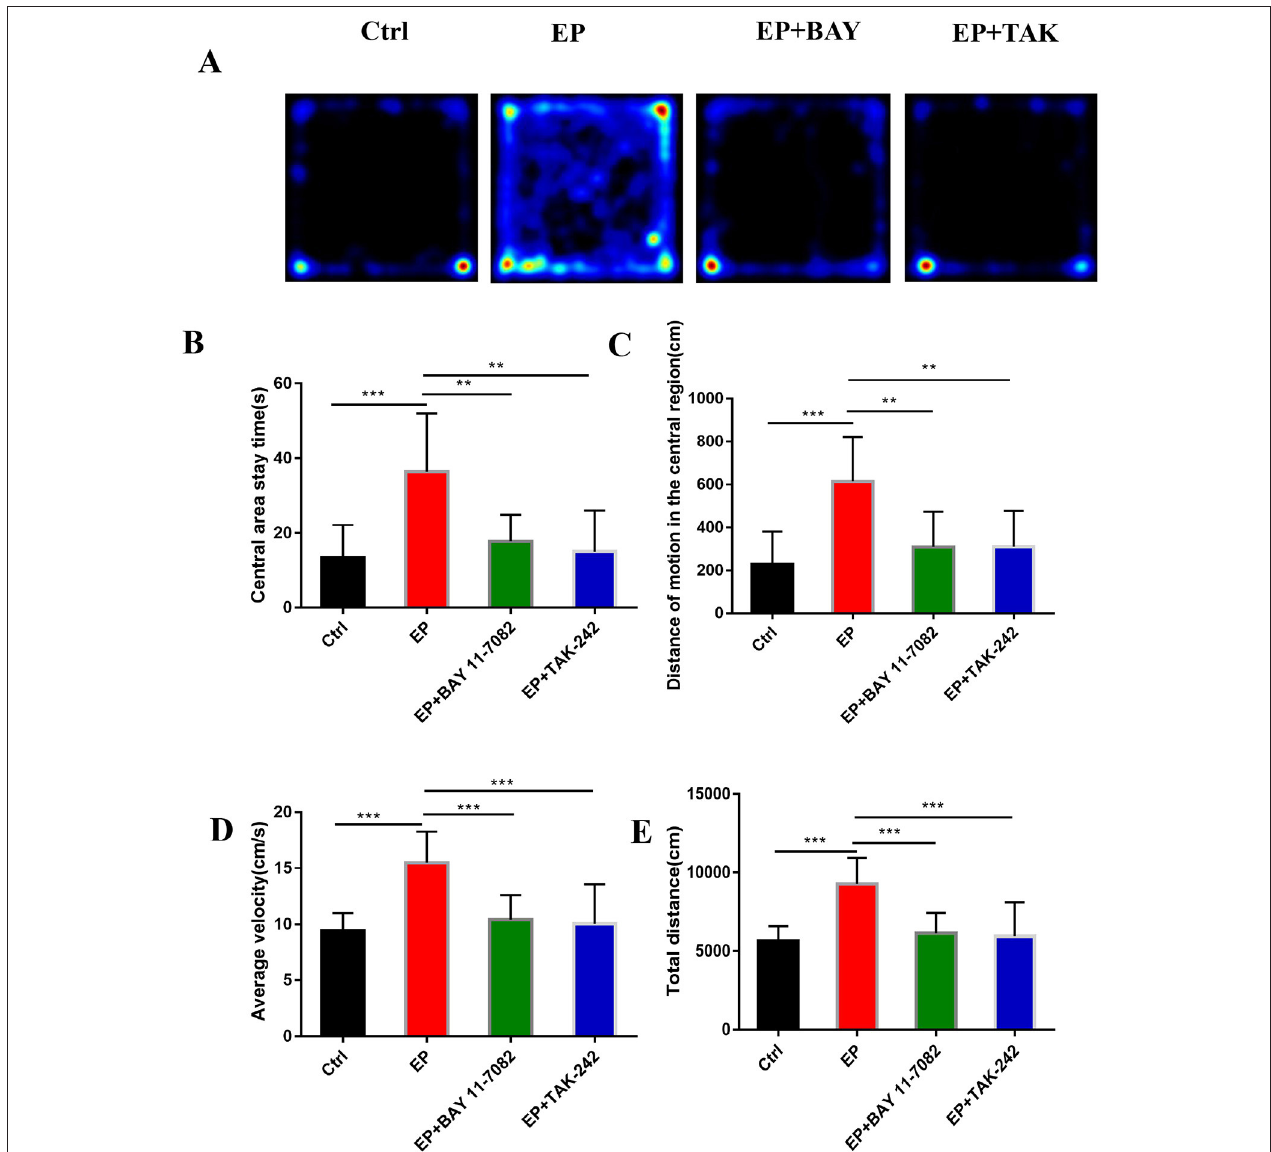
FIGURE 6 | (A–E) The effect of each group’s condition on the emotional and behavioral functions of rats detected using the OFP. * P < 0.05; ** P < 0.01; *** P <